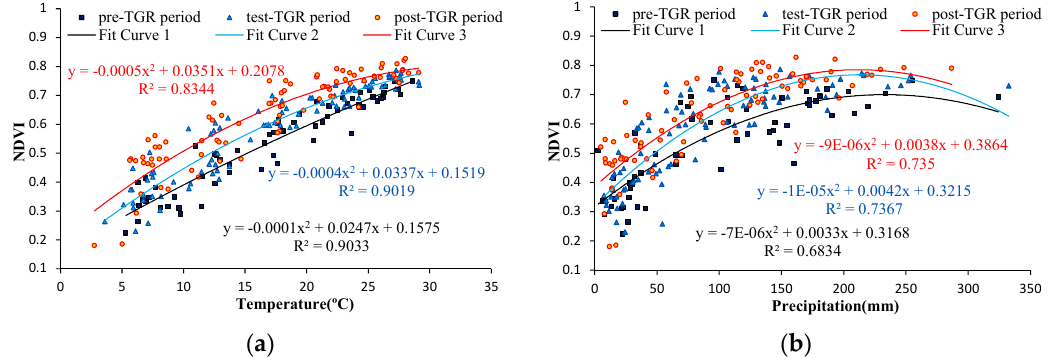
Figure 8. The scatter plot of NDVI–temperature and NDVI–precipitation in three periods: ( a ) nonlinear relationship between NDVI and temperature; ( b ) nonlinear relationship between NDVI and precipitation.